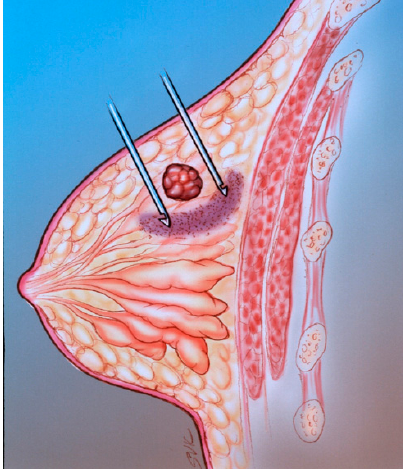
Figure 5. The diagram illustrates mammographically-guided SLNB. The pink semicircular region is the area of the peritumoral injection.